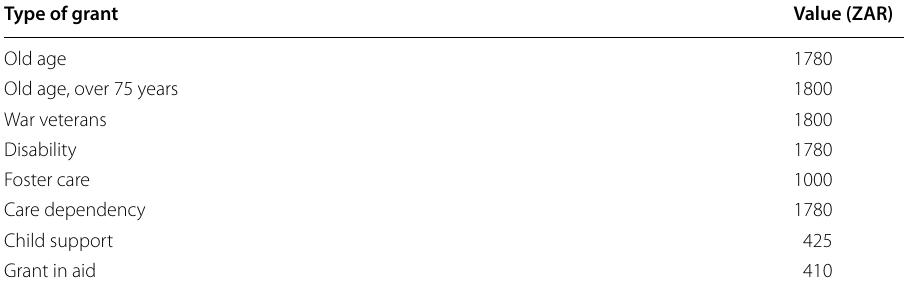
Table 2 Monthly values of social grant support. Source: National Treasury (2019)